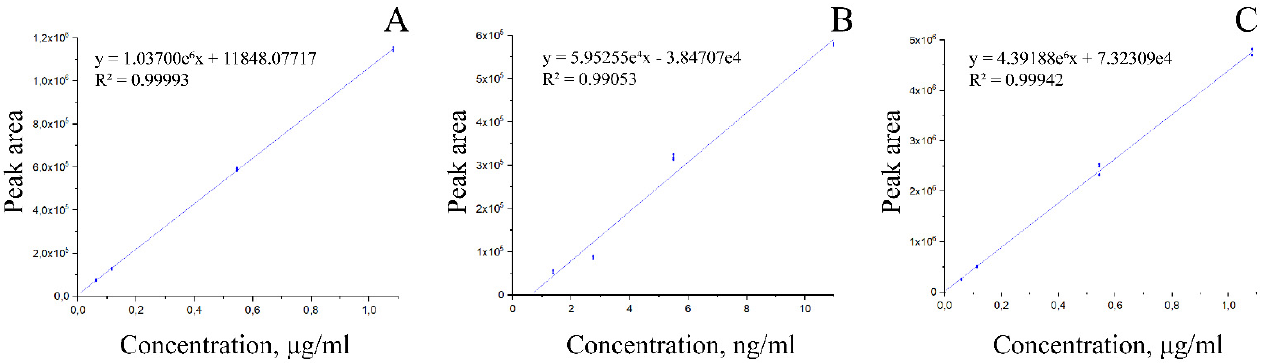
Figure 3. Calibration curves of hydroxycinnamic acid derivatives obtained by liquid chromatography. The vertical axis corresponds to the chromatographic signal (peak area) and the horizontal axis shows the concentrations of the calibration solutions of 3-methoxy-4-acetamidocinnamic acid ( A ), ferulic acid ( B ), and 3,4-dimethoxycinnamic acid ( C ). Table 3. Quantitative content of 3 cinnamic acid derivatives in coffee extracts: 3M4ACA—3-meth-